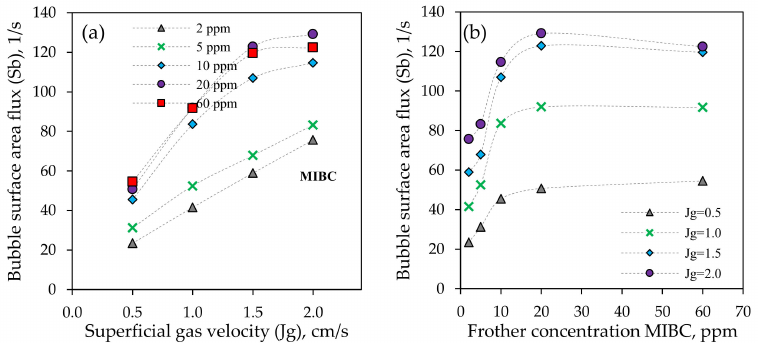
Figure 6. Bubble surface area flux (S b ) as a function of ( a ) the Superficial gas velocity and ( b ) MIBC frother concentration.